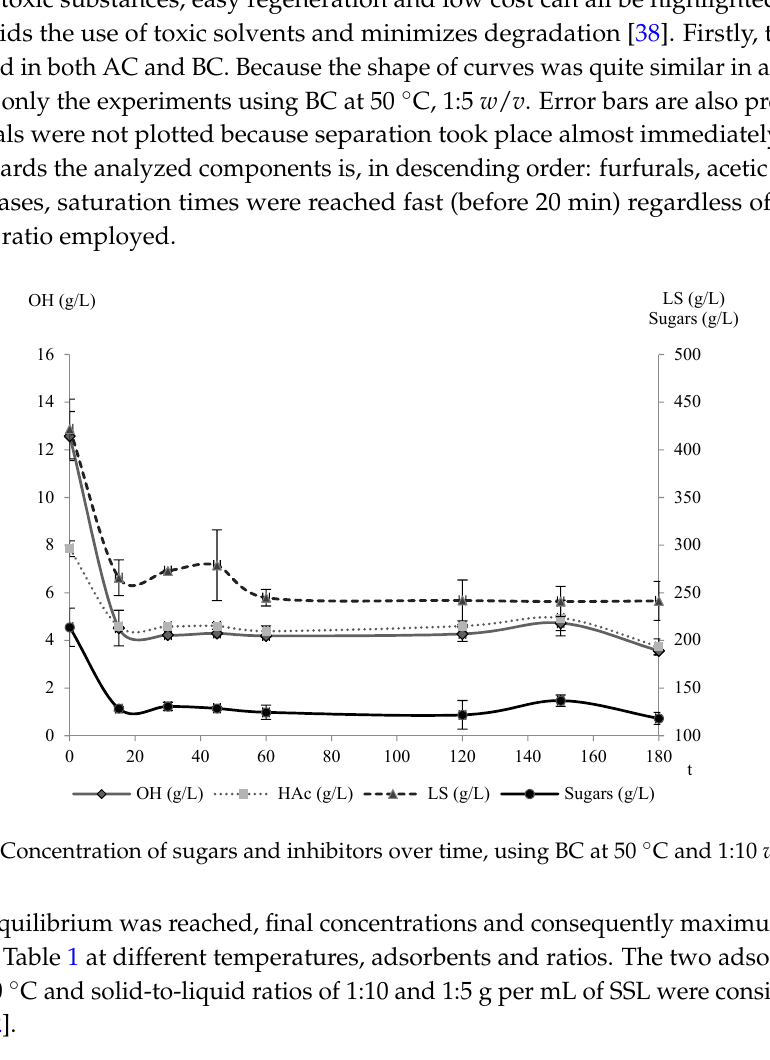
Table 1. Detoxification by means of adsorption: influence of temperature, adsorbent and ratio.